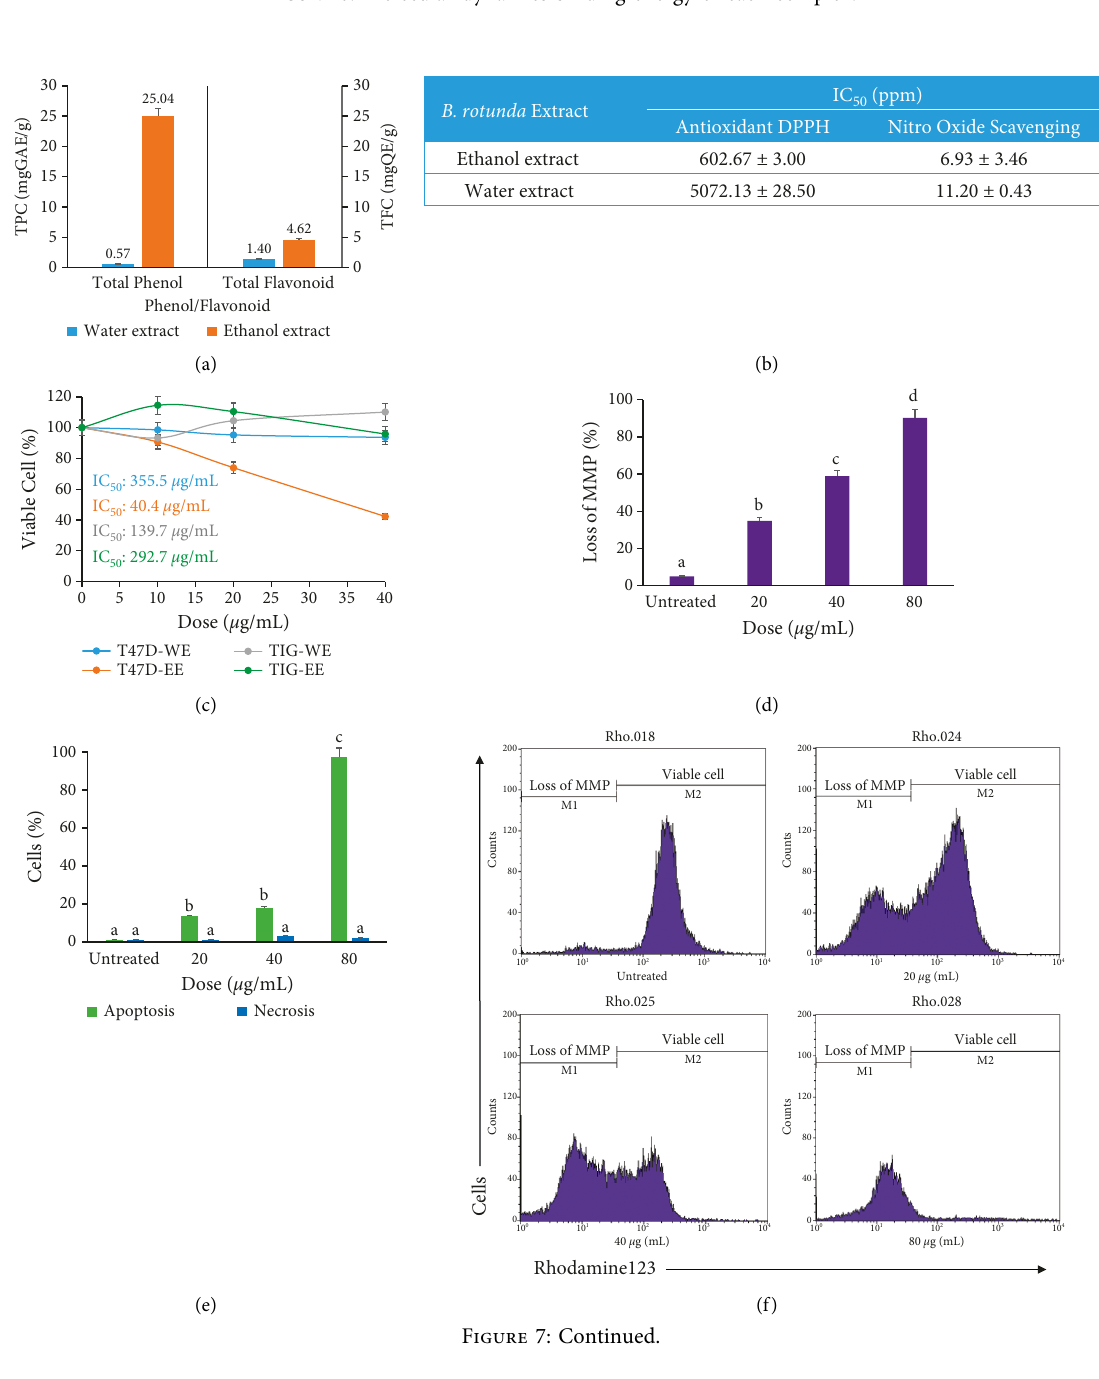
Figure 6: Molecular dynamics binding energy of each complex.